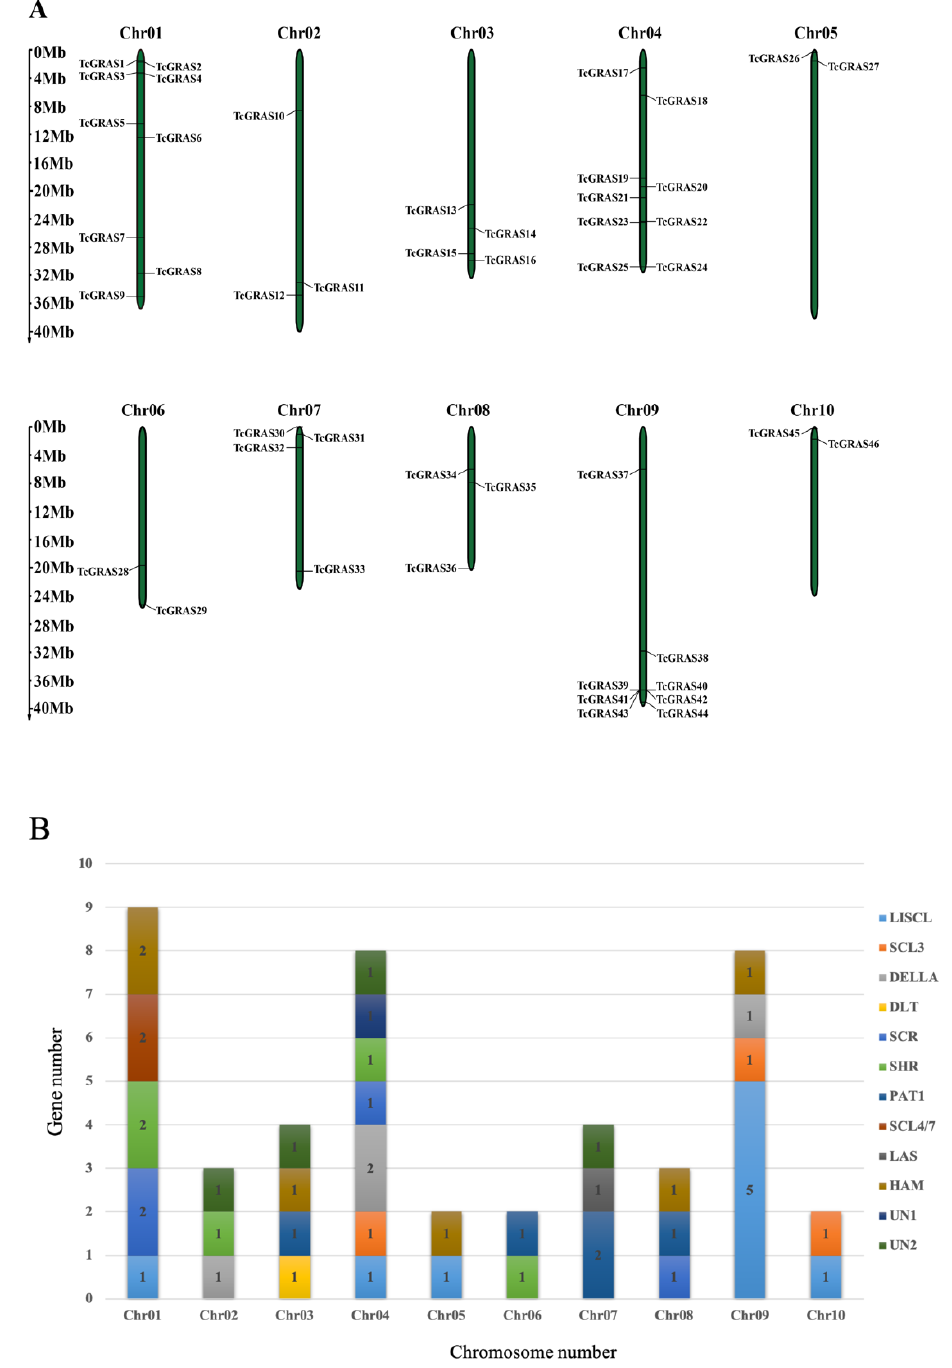
Figure 3. ( A ) Physical distribution of TcGRAS genes among 10 chromosomes. ( B ) Number of TcGRAS subfamilies on each chromosome.